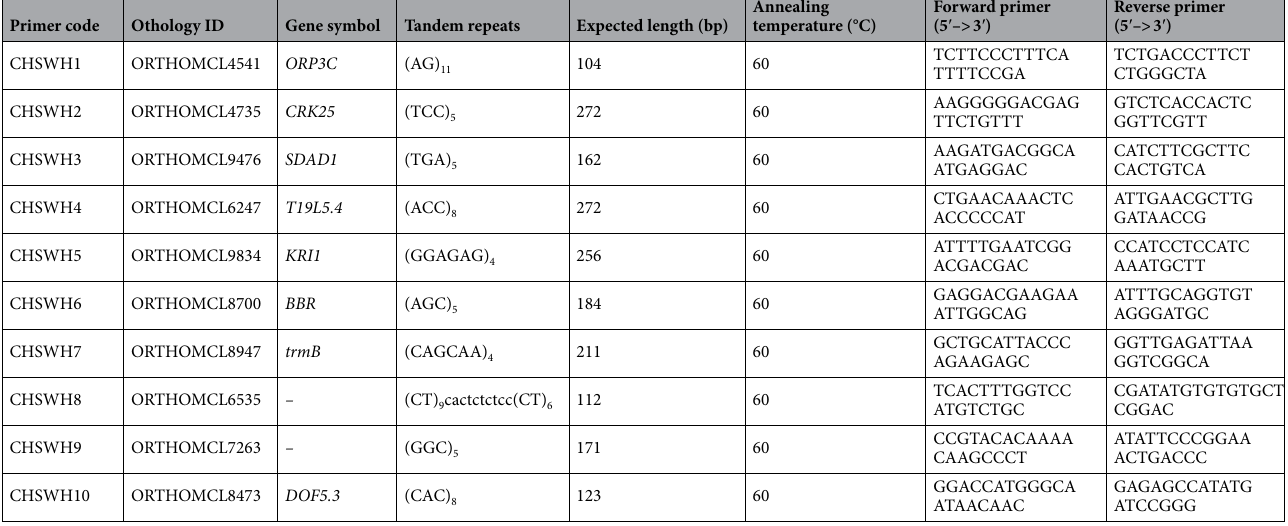
Table 1. Primer and fragment length for selected genes.